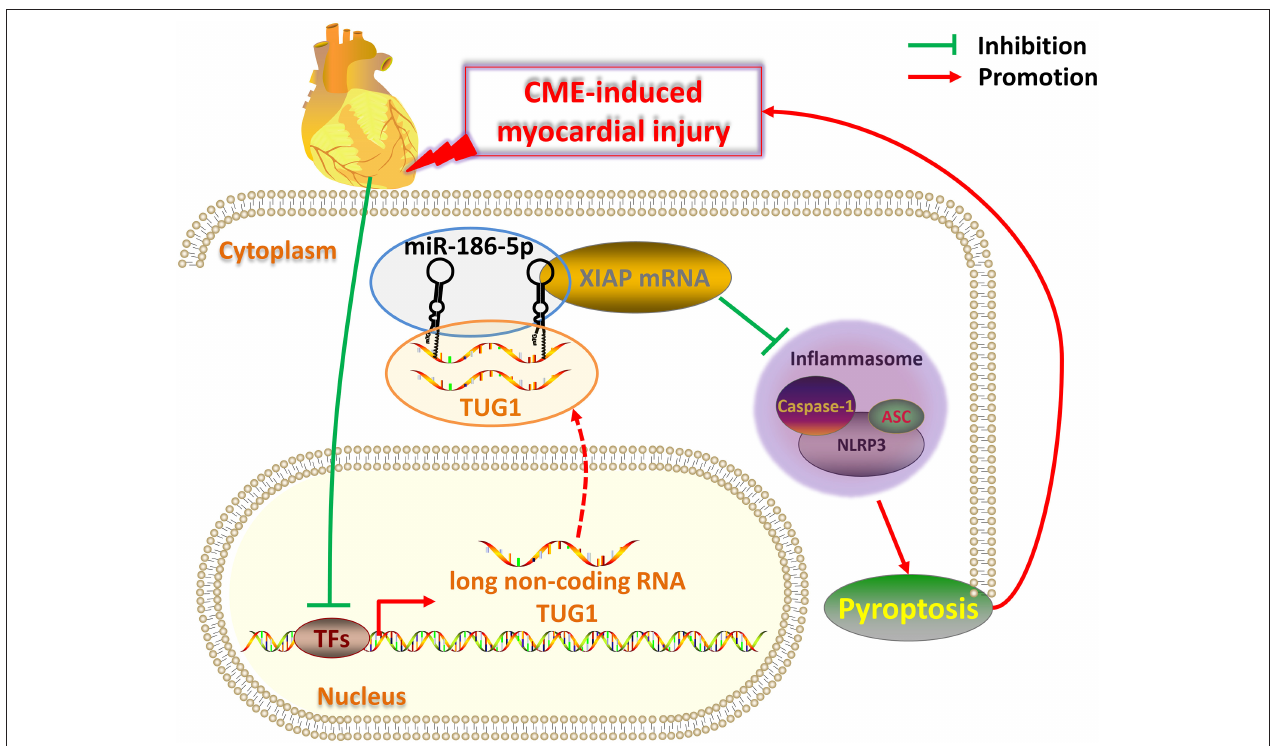
FIGURE 9 | Schematic of the role of TUG1 in CME-induced myocardial injury. Once CME occurs, the expression of lncRNA TUG1 in cardiomyocytes is inhibited. The TUG1 level in the cytoplasm of cardiomyocytes significantly decreases, and the competitive adsorption of miR-186-5p weakens accordingly, which leads to the increase of miR-186-5p level. The increased miR-186-5p directly binds to the 3’ UTR of XIAP mRNA and promotes its degradation, resulting in a significant decrease in XIAP expression. The decrease in XIAP leads to an increase in NLRP3 inflammasomes (composed of NLRP3, ASC, caspase-1 protein) and promotes